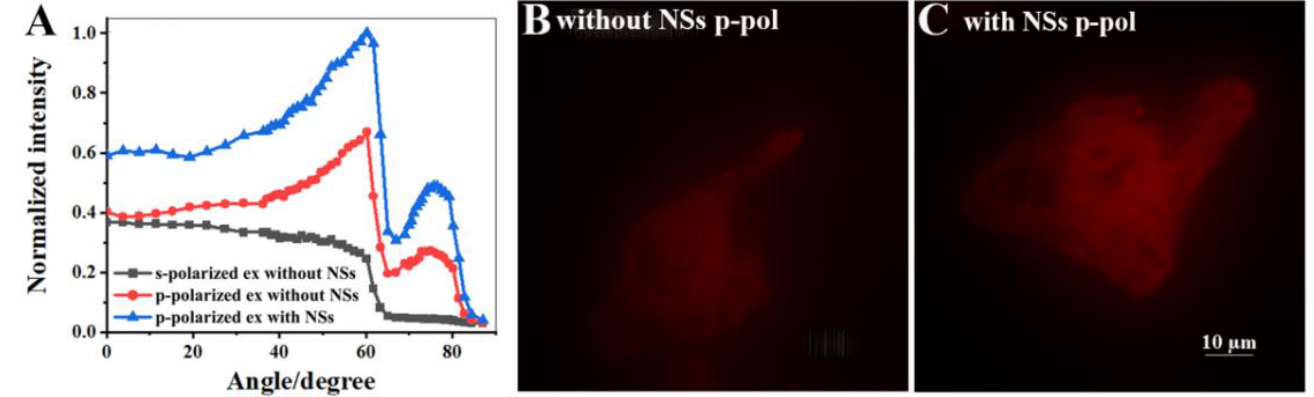
Figure 4. ( A ) The relationship between the normalized intensity of RhB-dyed cell images and the excitation angle. The RhB-dyed cell images from SPR excitation ( B ) without and ( C ) with Au-Ag NSs modification.